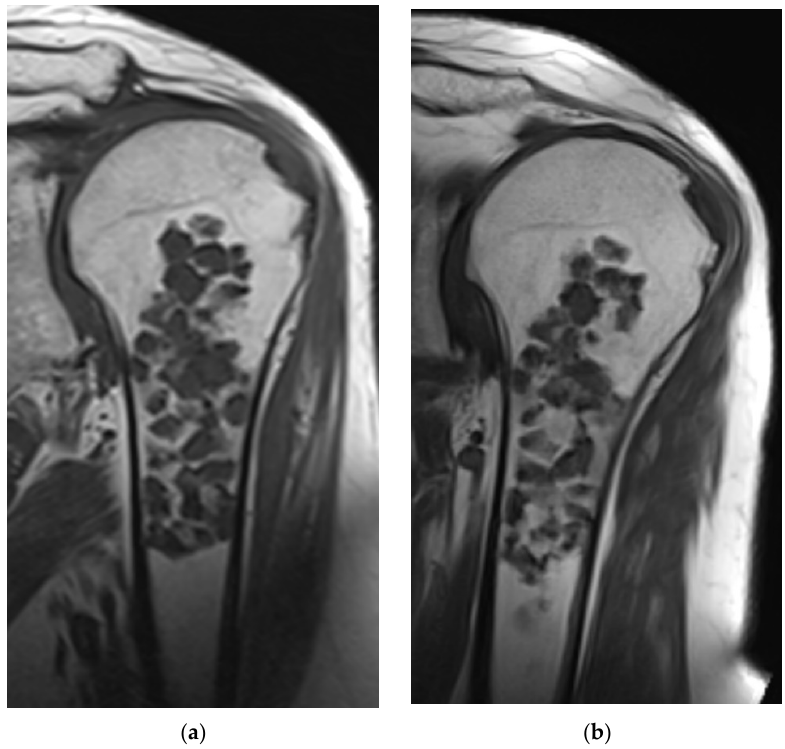
Figure 3. ( a , b ): Coronal Spin Echo T1 weighted images of the same cartilaginous tumor three years apart. Signs of fatty replacement are seen peripheral and central in the tumor.